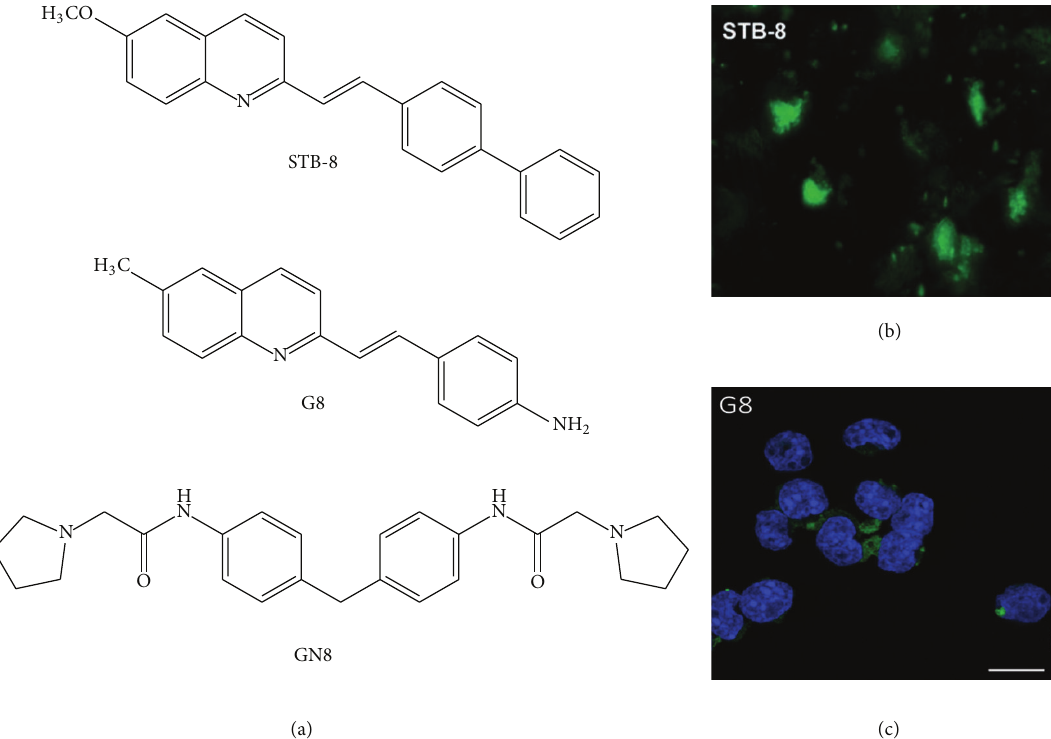
Figure 6: (a) Chemical formula of the three promising antiprionic compounds and in vitro staining with (b) STB-8 compound ( 𝛽 -amyloid plaques) and (c) G8 compound (PrP Sc